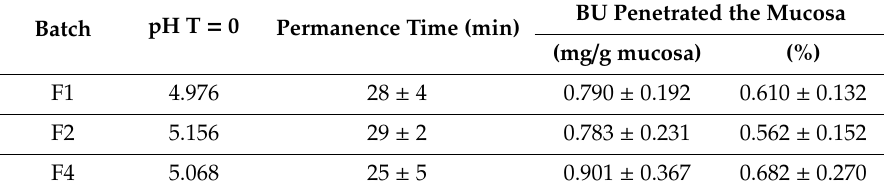
Table 5. Chemical and technological characterization of the modified